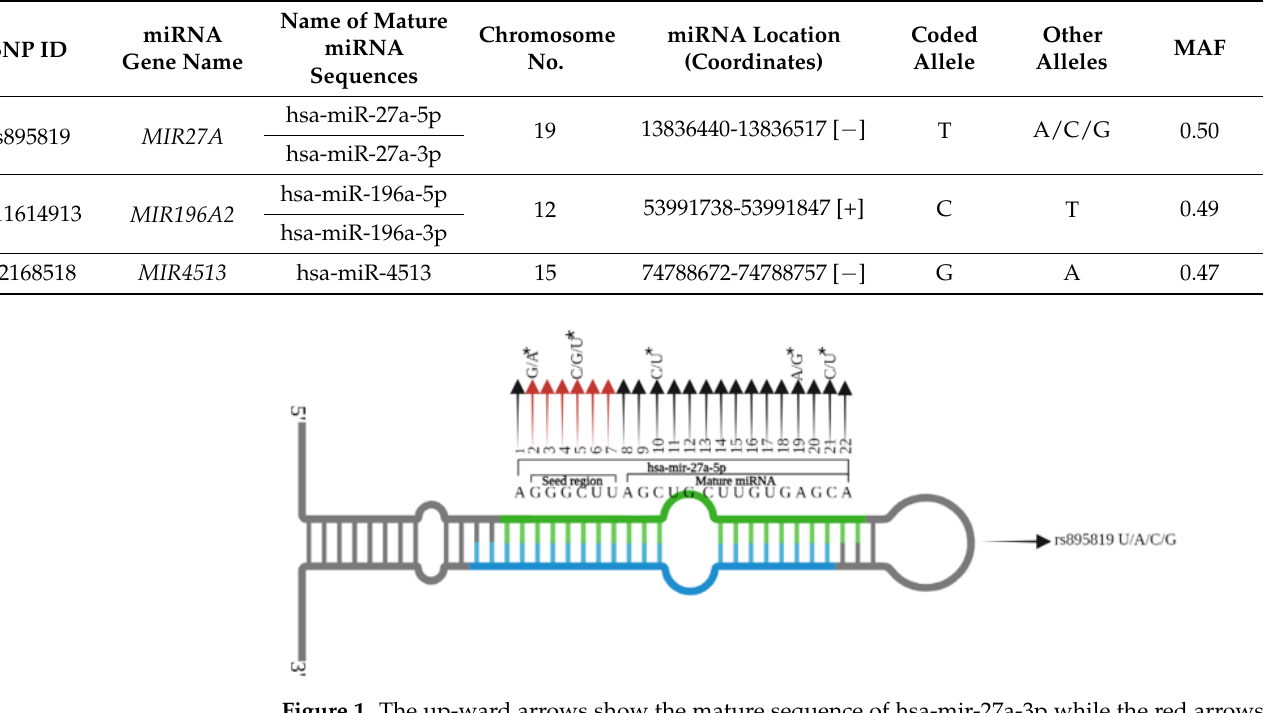
Figure 1. The up-ward arrows show the mature sequence of hsa-mir-27a-3p while the red arrows indicate the seed region (6 nts). Stare (*) Indicates the location of all SNPs in hsa-mir-27a-5p.